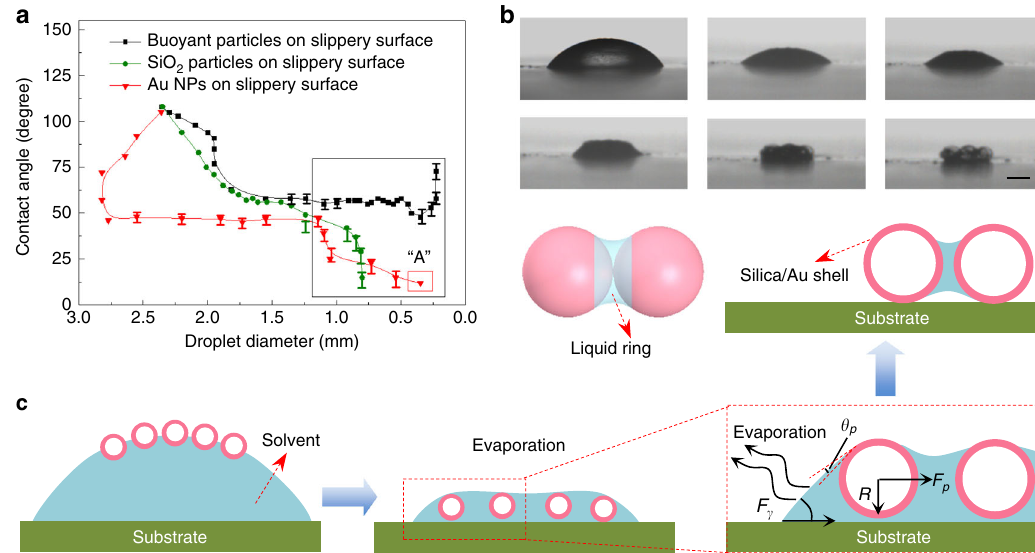
Fig. 3 Evaporation processes and mechanism. a The relationship between contact angle and droplet diameter for various particulates. The value of droplet diameter marked “ A ” is estimated owing to the limit of observation. b The fi nal drying stage of the evaporation process for a droplet containing buoyant- particulates on slippery surface. The scale bar is 50 μ m. c Schematics illustration of the close-packed particle aggregation process on a slippery substrate by evaporating a droplet containing fl oating particles. The inset fi gure displays the light-weight particle in the vicinity of the leading edge of the thin fi